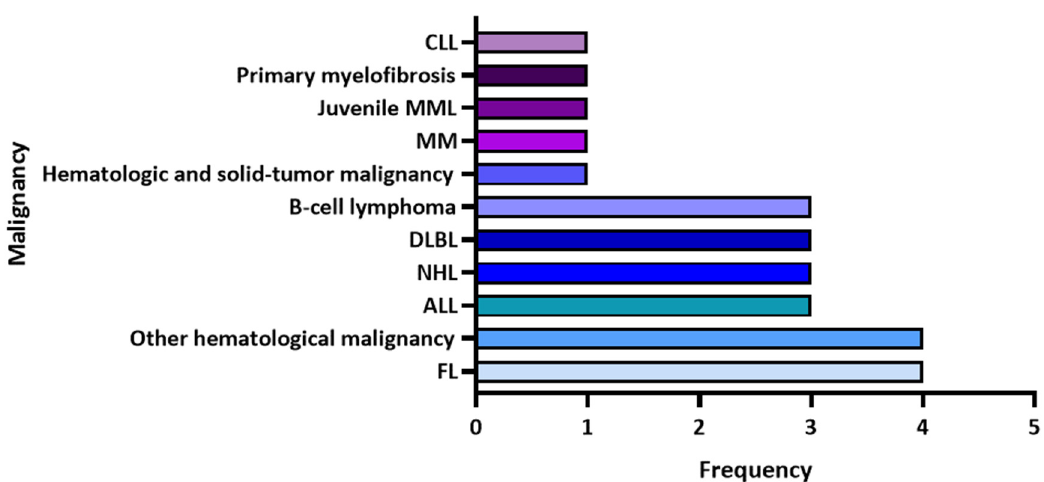
Figure 2. The frequency of hematological malignancies reported in the identified articles. CLL: chronic lymphocytic leukemia, MML: myelomonocytic leukemia, MM: multiple myeloma, HIV: human immunodeficiency virus, DLBL: diffused large B-cell lymphoma, NHL: non-Hodgkin’s lymphoma, ALL: acute lymphocytic leukemia, FL: follicular lymphoma. 3.3. Dose, Time of Administration and Clinical Outcomes of CPT Table 2. Summary of included studies on CPT for COVID-19 patients with hematological malignan- The dose of CP varied from 200–300 mL per transfusion. CPT was administered at cies. variable time-points after hospital admission, with some patients receiving CPT as early as day 2 post-diagnosis with COVID-19, while most of the remaining patients received CPT as a last treatment option after approximately one month of hospitalization (Table 3).